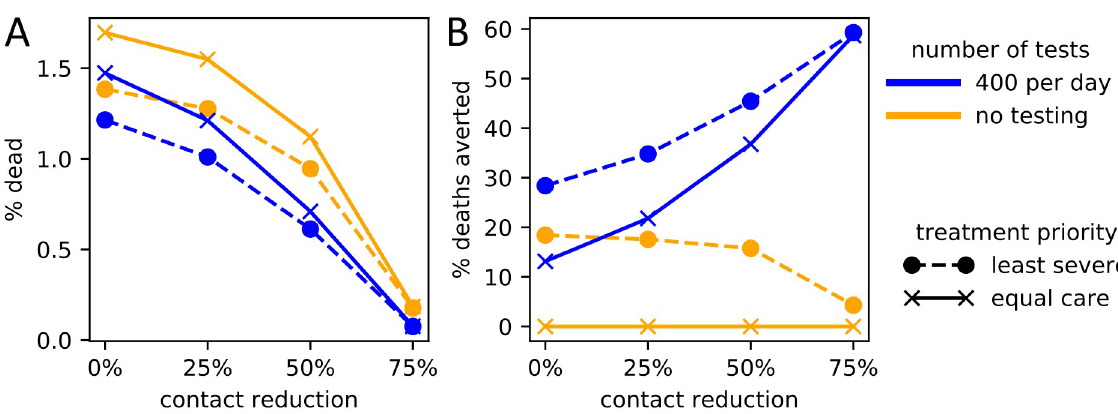
Fig 6. Interactions of the three policy domains on COVID-19-related deaths. The level of social contact reduction (x-axis) is plotted against combinations of testing policies (solid lines, gold: maximum testing, blue: no testing) and triage policies (dashed lines, circles: treat least severely infected first; solid lines, crosses: imperfect but equal care). Y-values are averages across 1,000 parameter choices with 100 replicates each. (A) Policy choices versus proportion dead (y-axis). (B) Relative effects of policy choices in reducing the proportion dead (y-axis), compared to the worst-case scenario of no testing and imperfect-but-equal-care triage